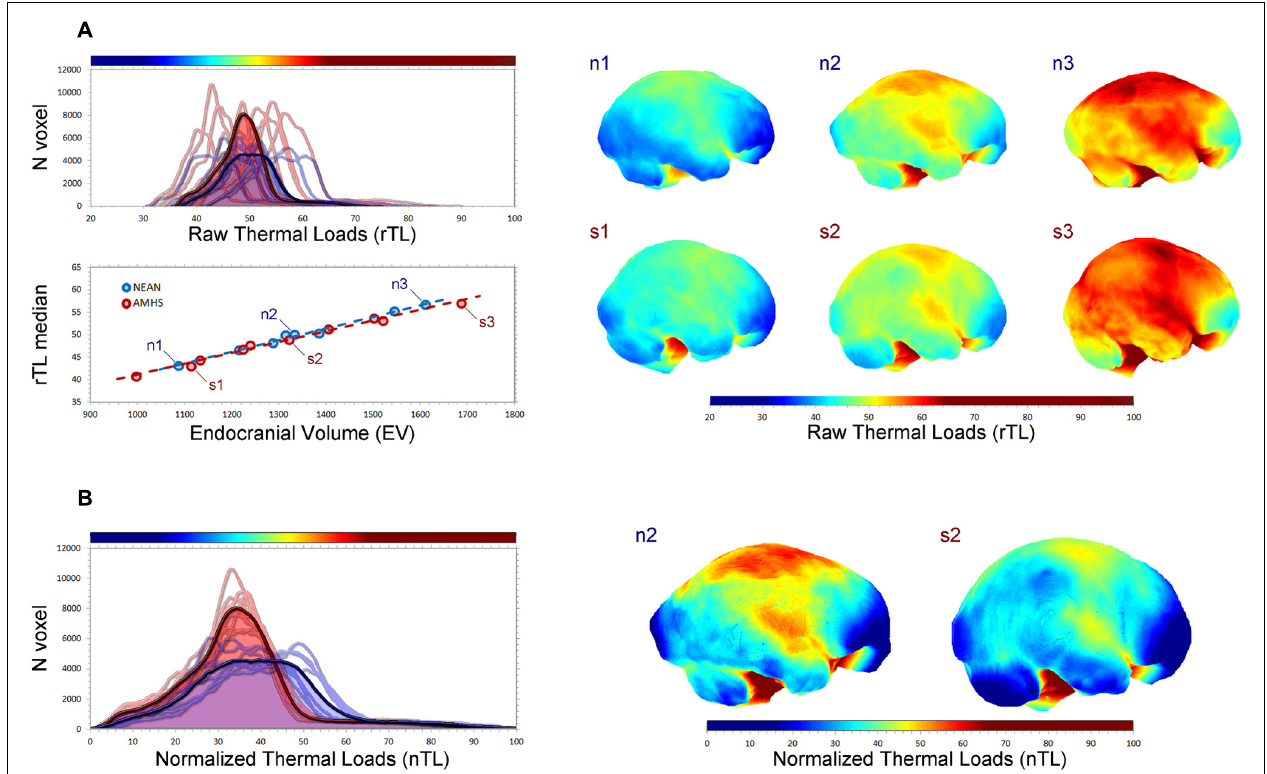
for each individual and for their average curve (bold lines). The correlation between endocranial volume and median thermal values (bottom left) shows that size is the major determinant of the overall figure. Mapping the values (right) allows the visualization of local changes associated with size differences. In (B) heat values are normalized according to their range distribution, from 0 to 100. Despite the similar size, modern humans and Neanderthals display different curves, suggesting local differences in warming/cooling patterns of the endocranial surface as a function of their geometry. The normalized maps display such differences for the medium-size